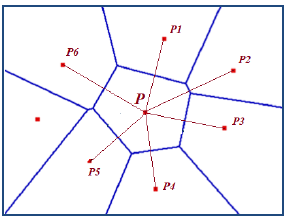
Figure 1: Selection and ranking points (Pi) of the set {V} neighboring to a point (P) during treatment.